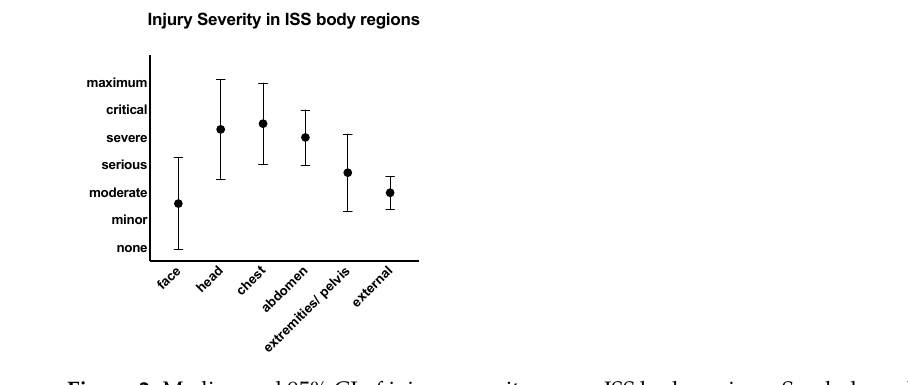
Figure 2. Median and 95% CI of injury severity across ISS body regions. Symbol: median, whiskers: 95% CI.